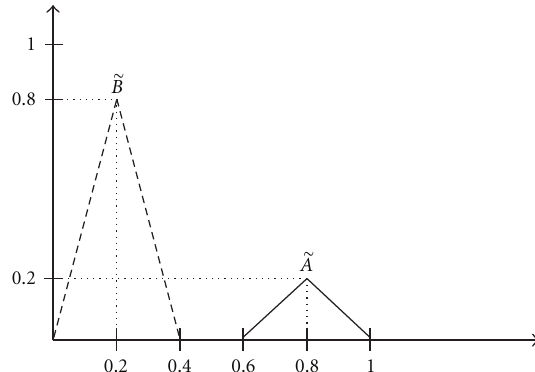
Figure 2: Group 1: Two generalized triangular fuzzy